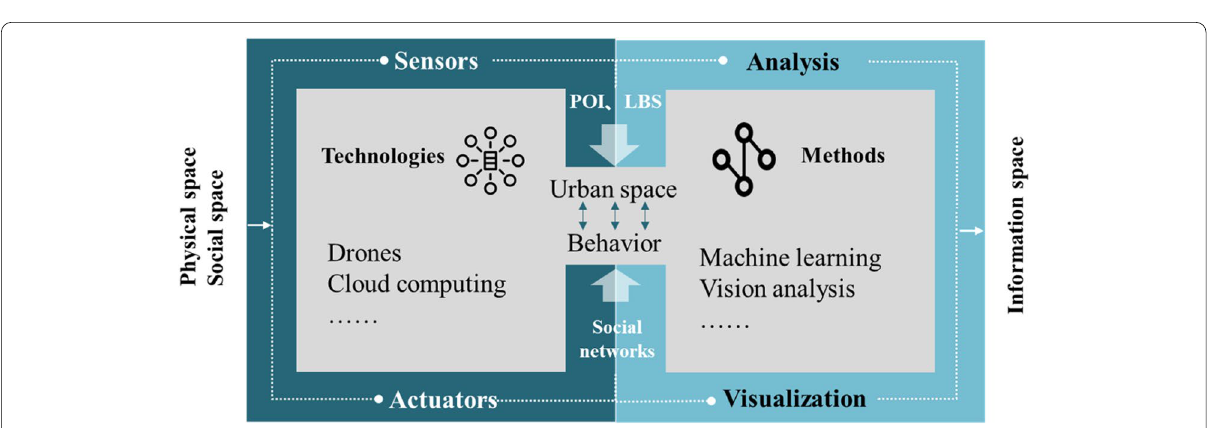
Fig. 3 Basic theoretical system of modern cities